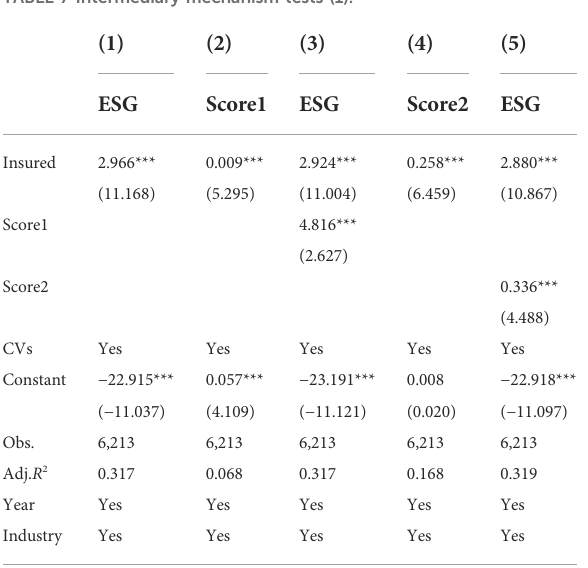
TABLE 7 Intermediary mechanism tests (1). TABLE 8 Intermediary mechanism tests